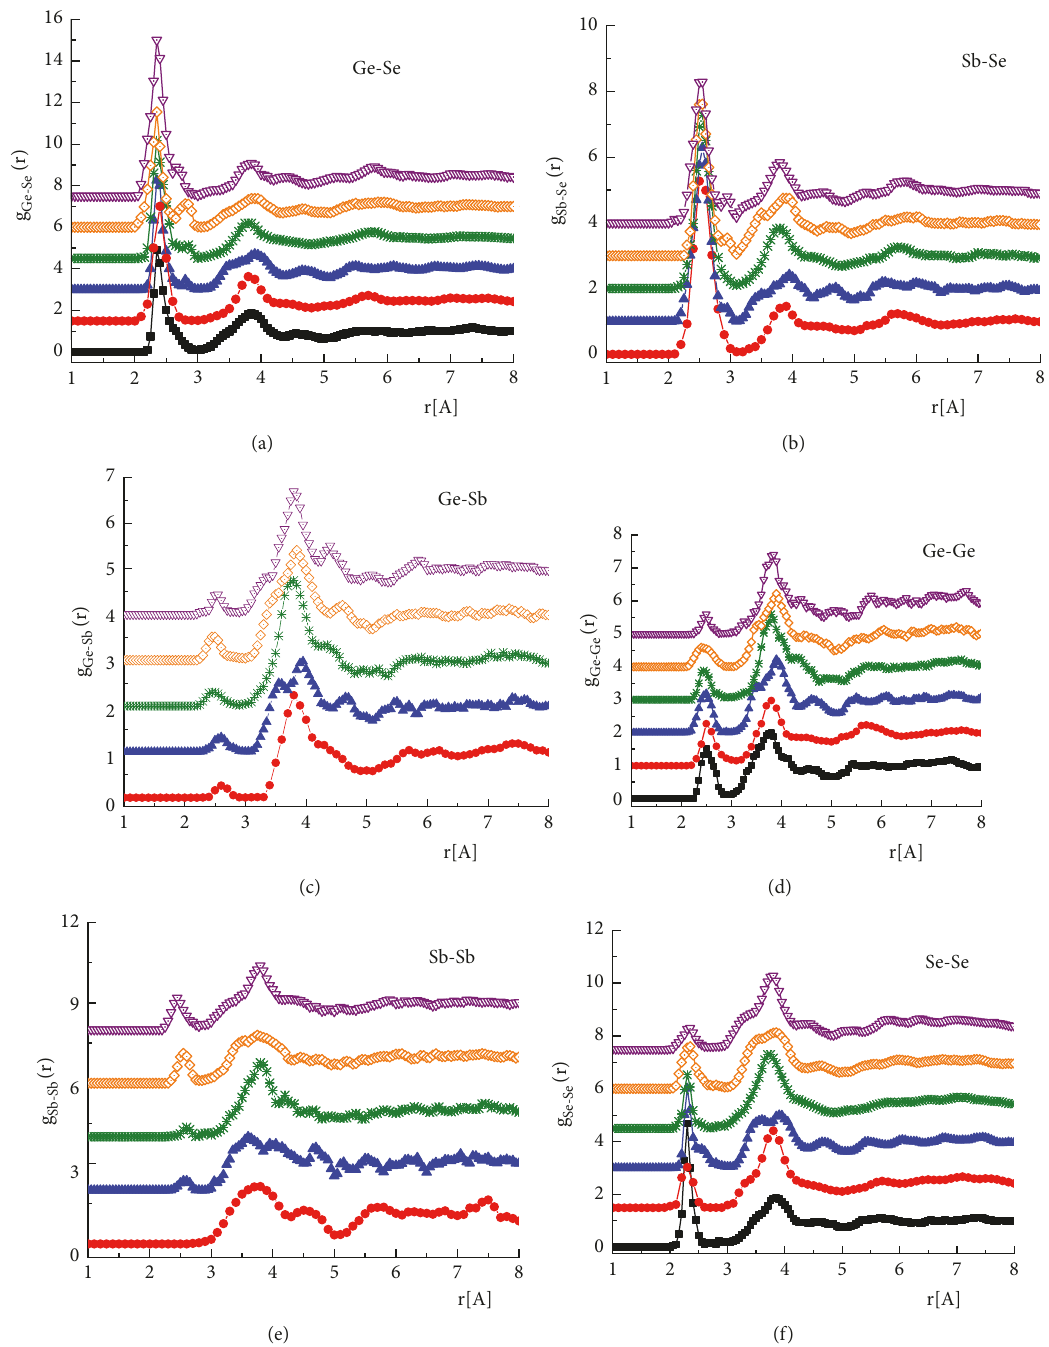
Figure 3: Partial atom pair correlation functions, 𝑔 ij ( r ) for the Ge 40 Se 60 (black square), Ge 35 Sb 5 Se 60 (red circle), Ge 32 Sb 8 Se 60 (blue triangle), Ge 27 Sb 13 Se 60 (green crosses), Ge 20 Sb 20 Se 60 (orange square), and Ge 15 Sb 25 Se 60 (purple reverse triangle) compositions, obtained by RMC modeling of the Ge-Se (a), Sb-Se (b), Ge-Sb (c), Ge-Ge (d), Sb-Sb (e), and Se-Se (f) atom pairs. For better clarity, the curves are shifted